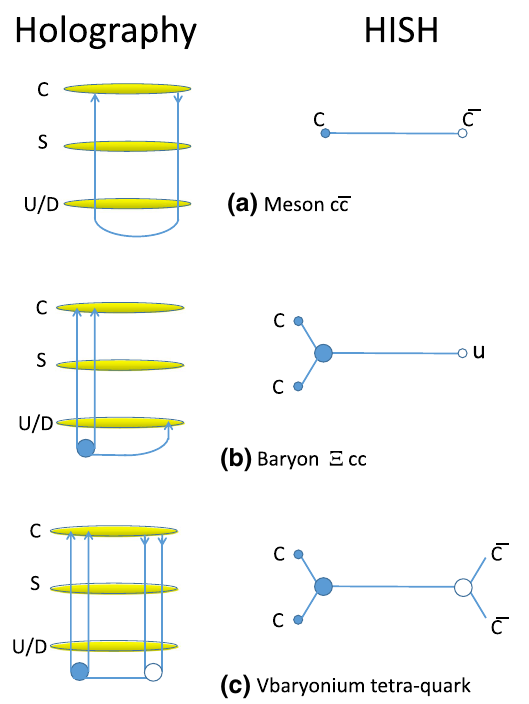
Fig. 2 The structure of hadrons in holography and HISH: a c ¯ c meson, e.g. J /(cid:3) . b Doubly charmed baryon, (cid:2) cc . c Fully charm V- baryonium tetraquark, conjectured structure of X ( 6900